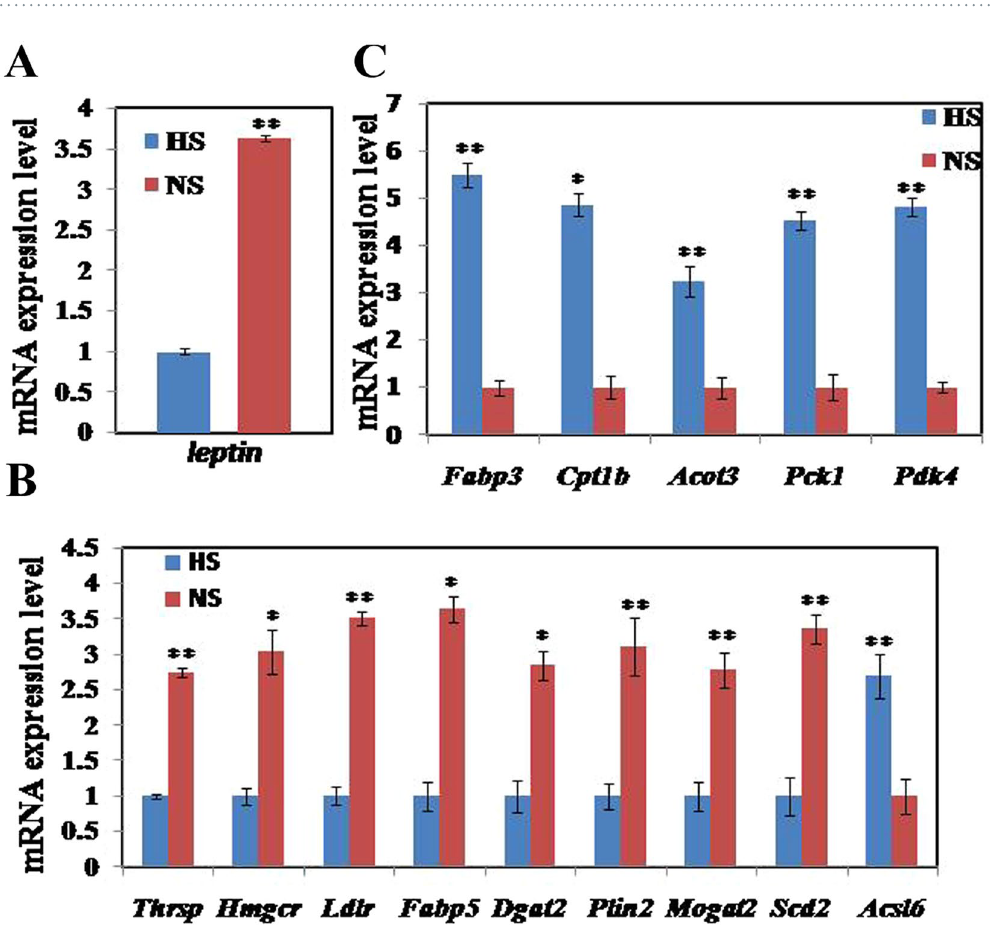
Figure 5. Changes in mRNA abundance of genes related to feed intake and lipid metabolism in adipose tissue after mice were fed 8 wk with HS and NS. ( A ) mRNA levels of lep, which is involved in food intake, was down- regulated. ( B ) mRNA levels of genes, involved in lipogenesis were down-regulated. ( C ) mRNA levels of genes involved in lipolysis or carbohydrate utilization were up-regulated. Data are means ± SEM, n = 3. * P < 0.05; ** P <